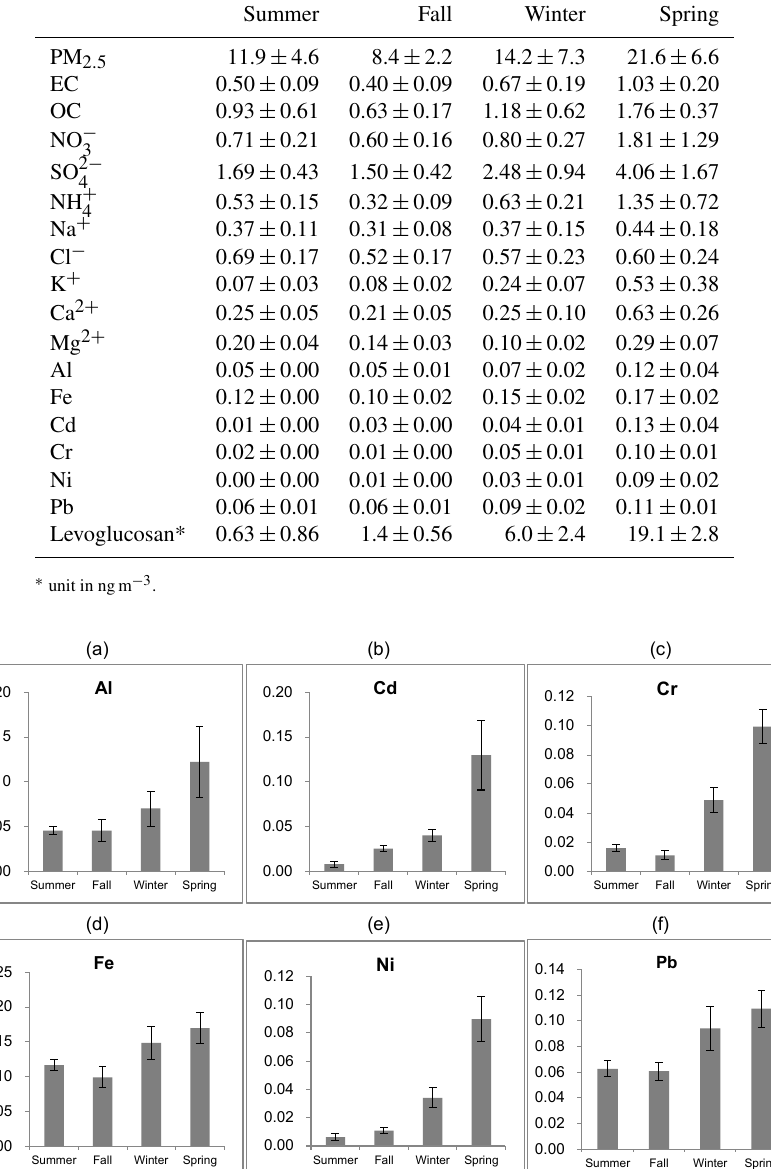
Table 2. Summary of mass concentration of PM 2 . 5 and its components (unit is µgm − 3 ).